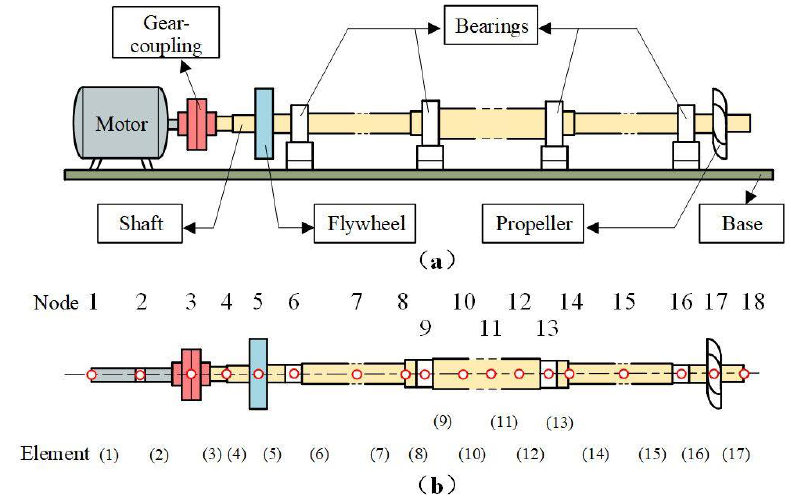
Figure 10. Structure diagram of GCRS. ( a ) Configuration of GCRS. ( b ) Diagram of nodes and elements spread. Table 1. Basic structure parameters of adopted gear coupling.